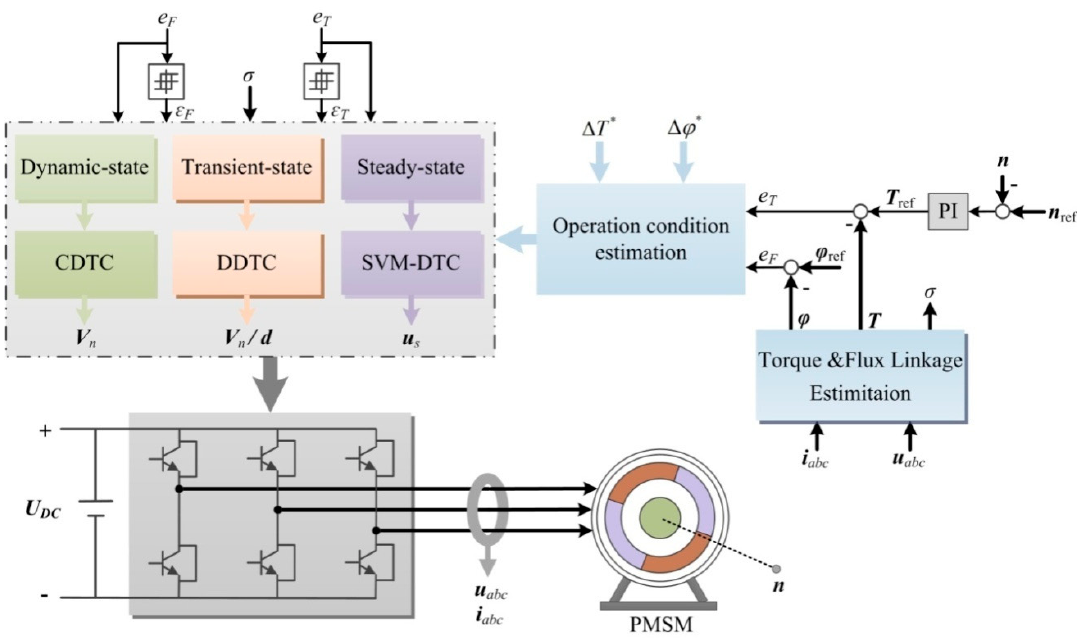
Figure 10. Schematic diagram of the CVM-DTC for PMSM.